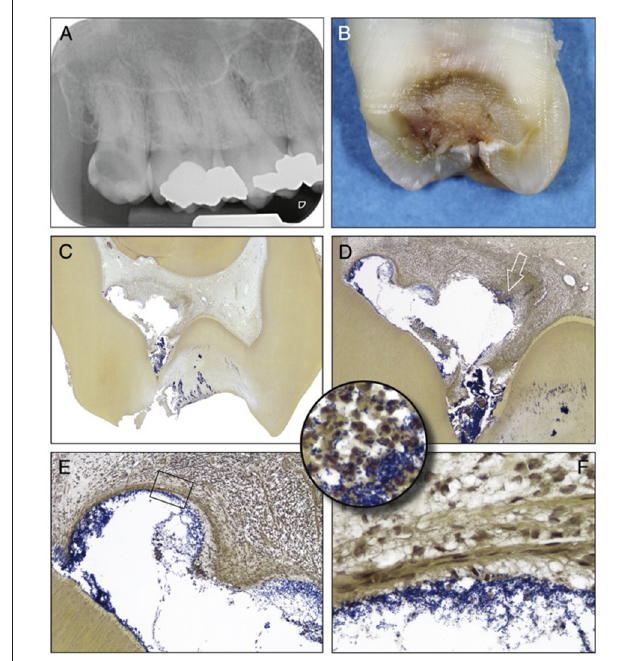
FIGURE 3 | Clinical vs. histological diagnosis of pulpitis: tooth with deep caries showing different phases of destruction and inflammation reflecting different histological diagnosises. (A) Radiograph of a maxillary third molar from a patient with severe spontaneous pain and clinical diagnosis of irreversible pulpitis. (B) Buccolingual sectioning plane of the tooth showing the infected dentine. (C) Histological section showing the dentine and pulp chamber in. An abscess is present buccally (Taylor’s modified Brown and Brenn, original magnification X8). (D) A detailed view of the abscess cavity with necrotic debris heavily colonized by bacteria. (E) Higher magnification view of the upper left portion of the abscess, the bacterial infiltration is limited by fibrous connective tissue. (F) High-power view of the rectangular area in (E) showing the fibrous connective tissue. (Circular inset) shows a high-power view of the area of the right portion of the abscess indicated by the arrow in (D) . Increased accumulation of bacteria and PMNs are evident. [Figure adapted from Ricucci et al. ( 69), J Endod. Permission obtained from